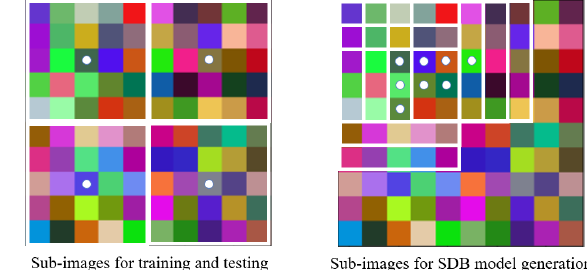
Figure 4. An illustration of sub-image extraction for training data (left) and SDB model generation